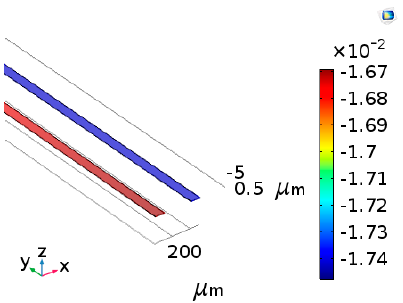
Figure 7. The simulation results of the cold junction of the thermocouple.